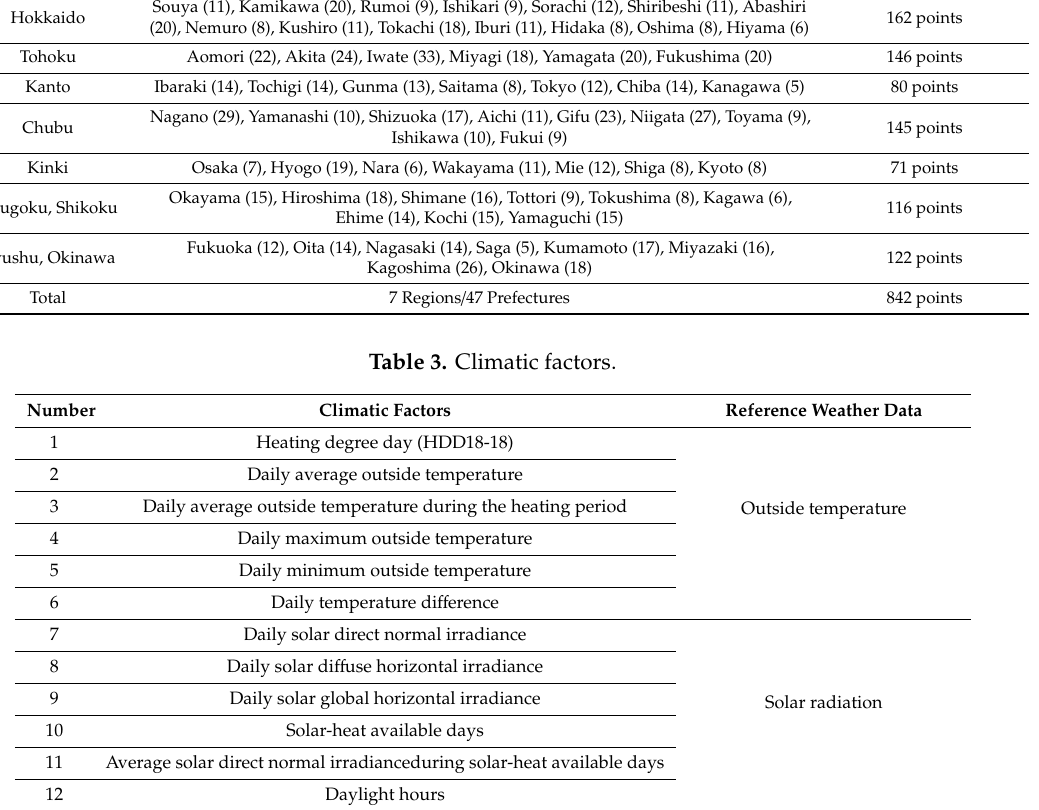
Table 4. Correlation between heating load of air-based solar heating system and climatic factors (12